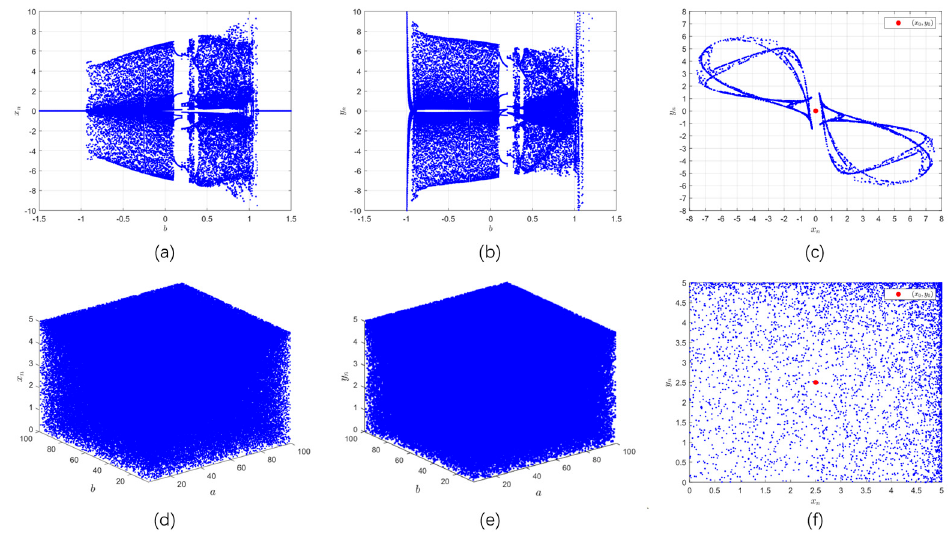
Figure 1. Bifurcation diagrams and trajectories of three existing 2D chaotic maps. Panel ( a – c ) display the Zeraoulia-Sprott map’s bifurcation diagrams under a = 3.8 and b ∈ ( − 1.5, 1.5), and its trajectory under (a, b) = (3.8, 0.6); ( d – f ) bifurcation diagrams and trajectories of the IZSM.